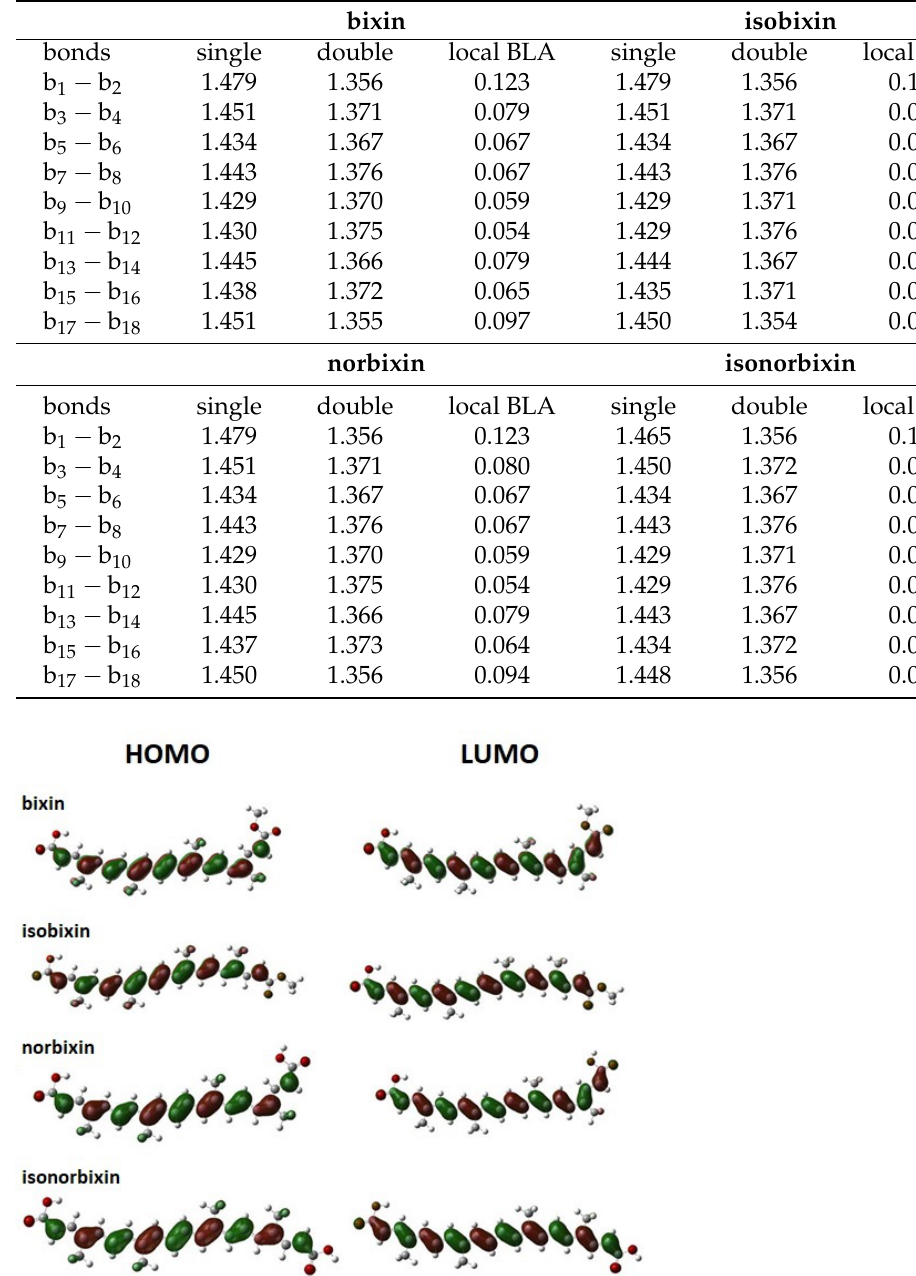
Figure A1. Schematic representation of the frontier molecular orbitals HOMO (left) and LUMO (right) of the molecular dyes in chloroform solution. These results were obtained by employing the B3LYP/6-31+G(d,p) level of